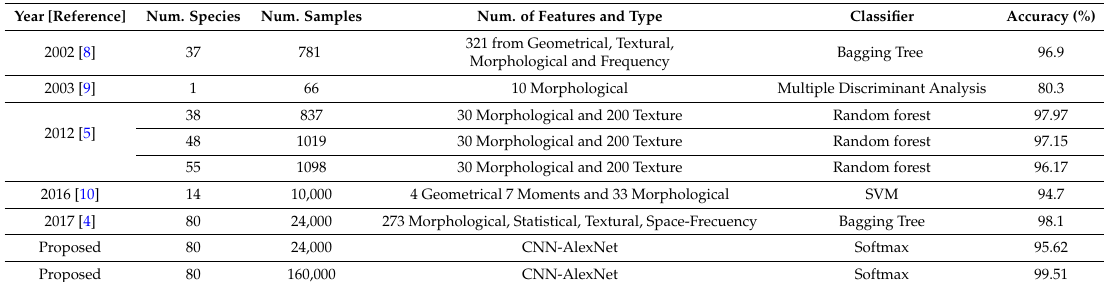
Table 1. Related work and results